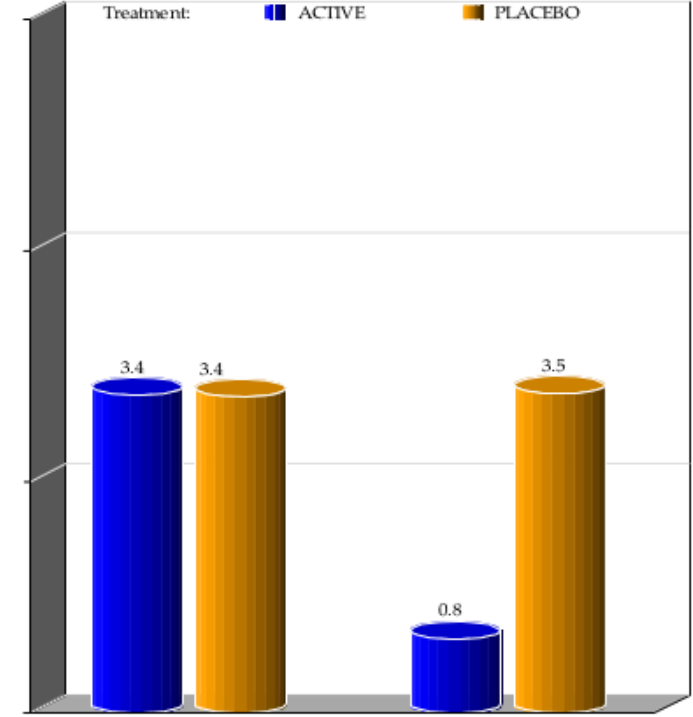
Figure 2. Mean value of FSDS considering the 13 questions at the first visit and at visit 4 weeks after the beginning of the treatment.